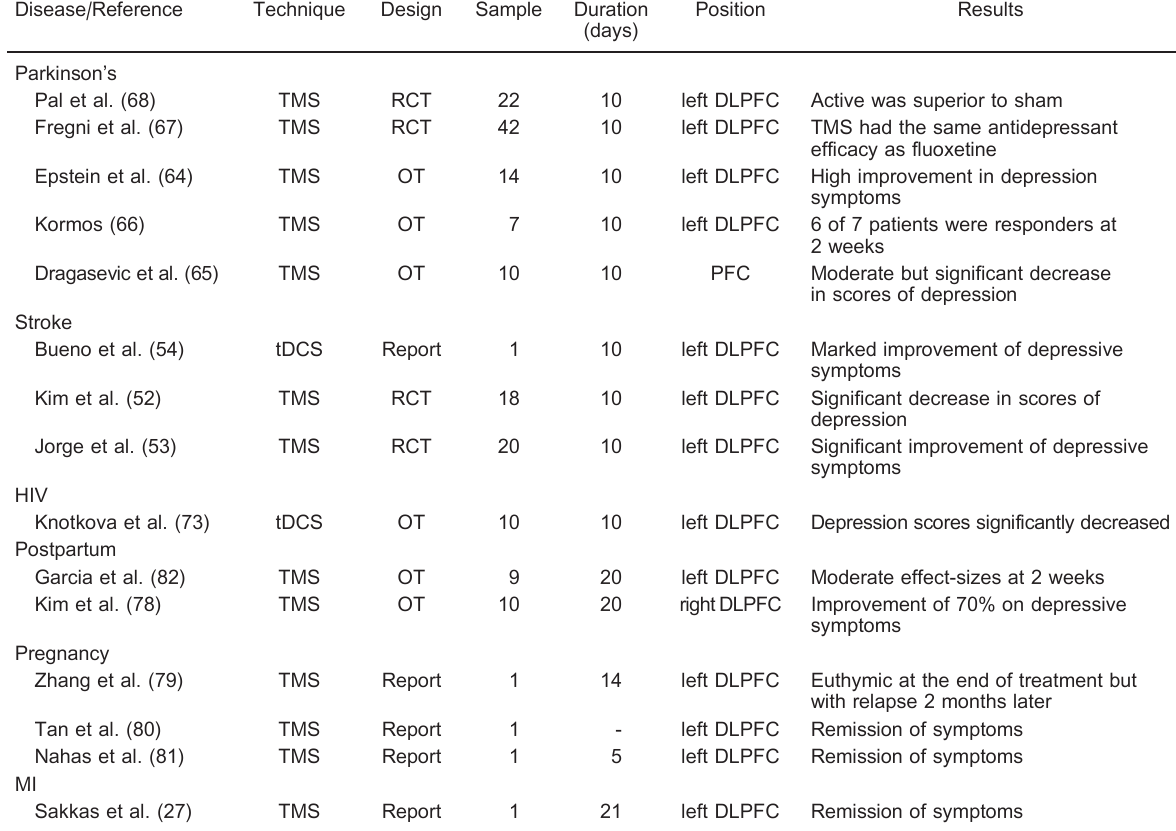
Table 1. Clinical studies of noninvasive brain stimulation in secondary